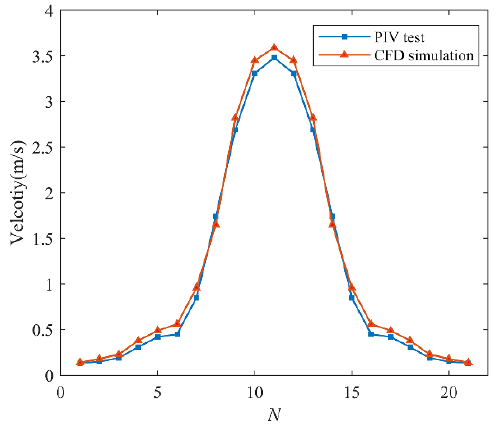
Figure 5. Results comparison of the CFD simulation and PIV experimental test.